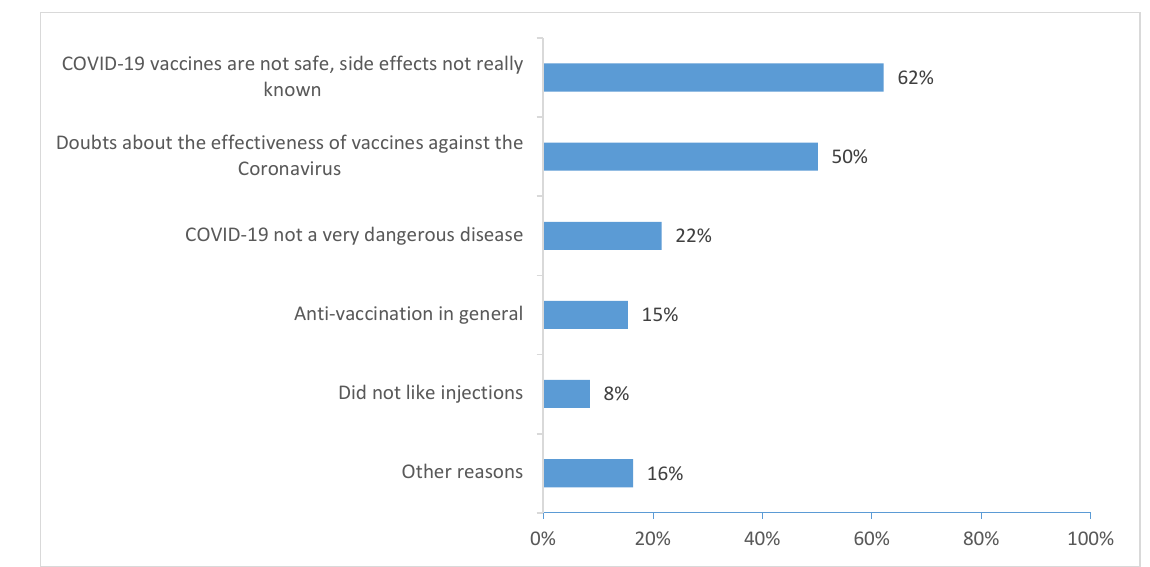
Figure 2. Reasons for unwillingness to vaccinate against COVID-19 (ERAS 2021 n = 2692) .